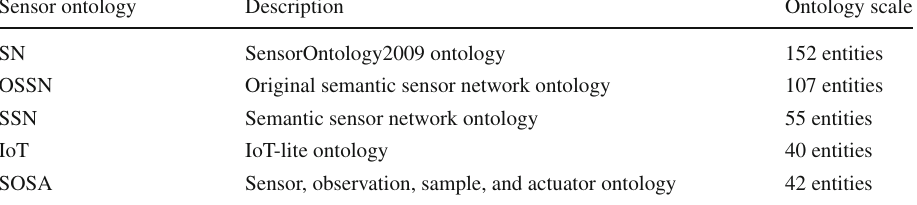
Table 19 Brief description of the five sensor ontologies